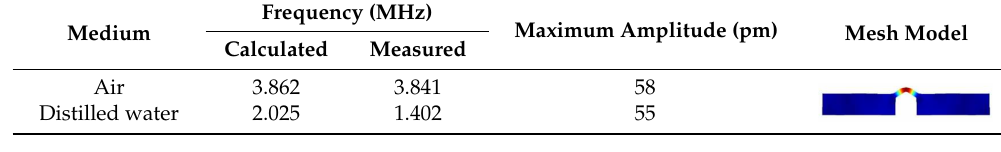
Table 1. Calculated and measured results of resonance frequencies of the disk-shaped resonator